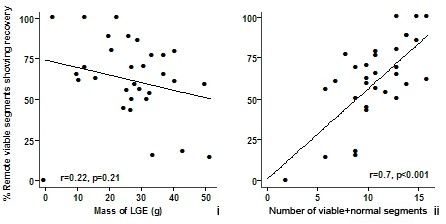
Panel i Correlation between recovery of remote and adjacent viable segments and the mass of late gadolinium enhancement (LGE) before surgery. Panel ii Correlation between recovery of remote and adjacent segments with the number of viable+normal segments.